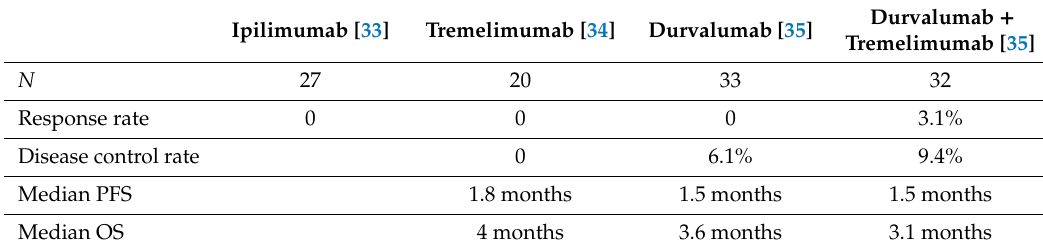
Table 4. Immune checkpoint inhibitors for pancreatic